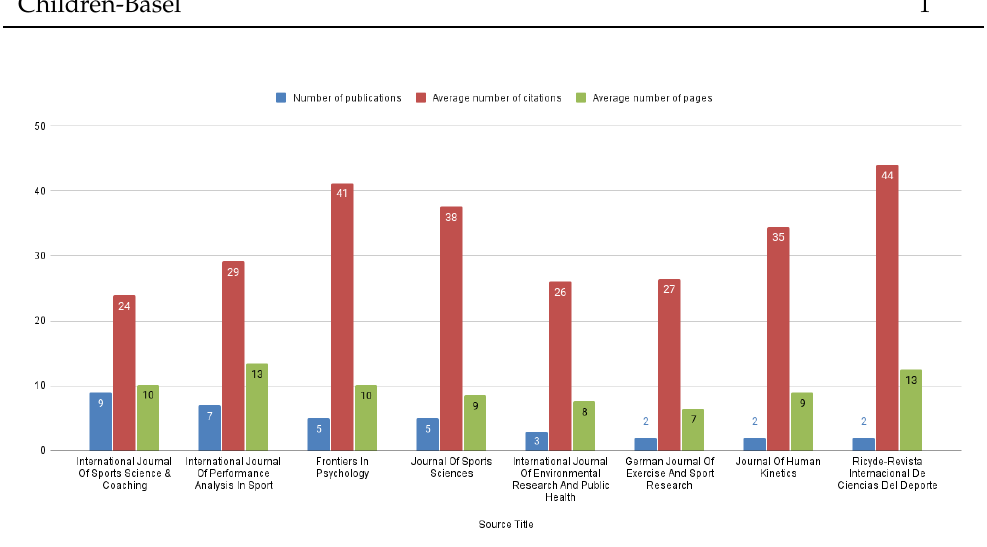
Figure 4. Sources of selected publications, average citations and average number of